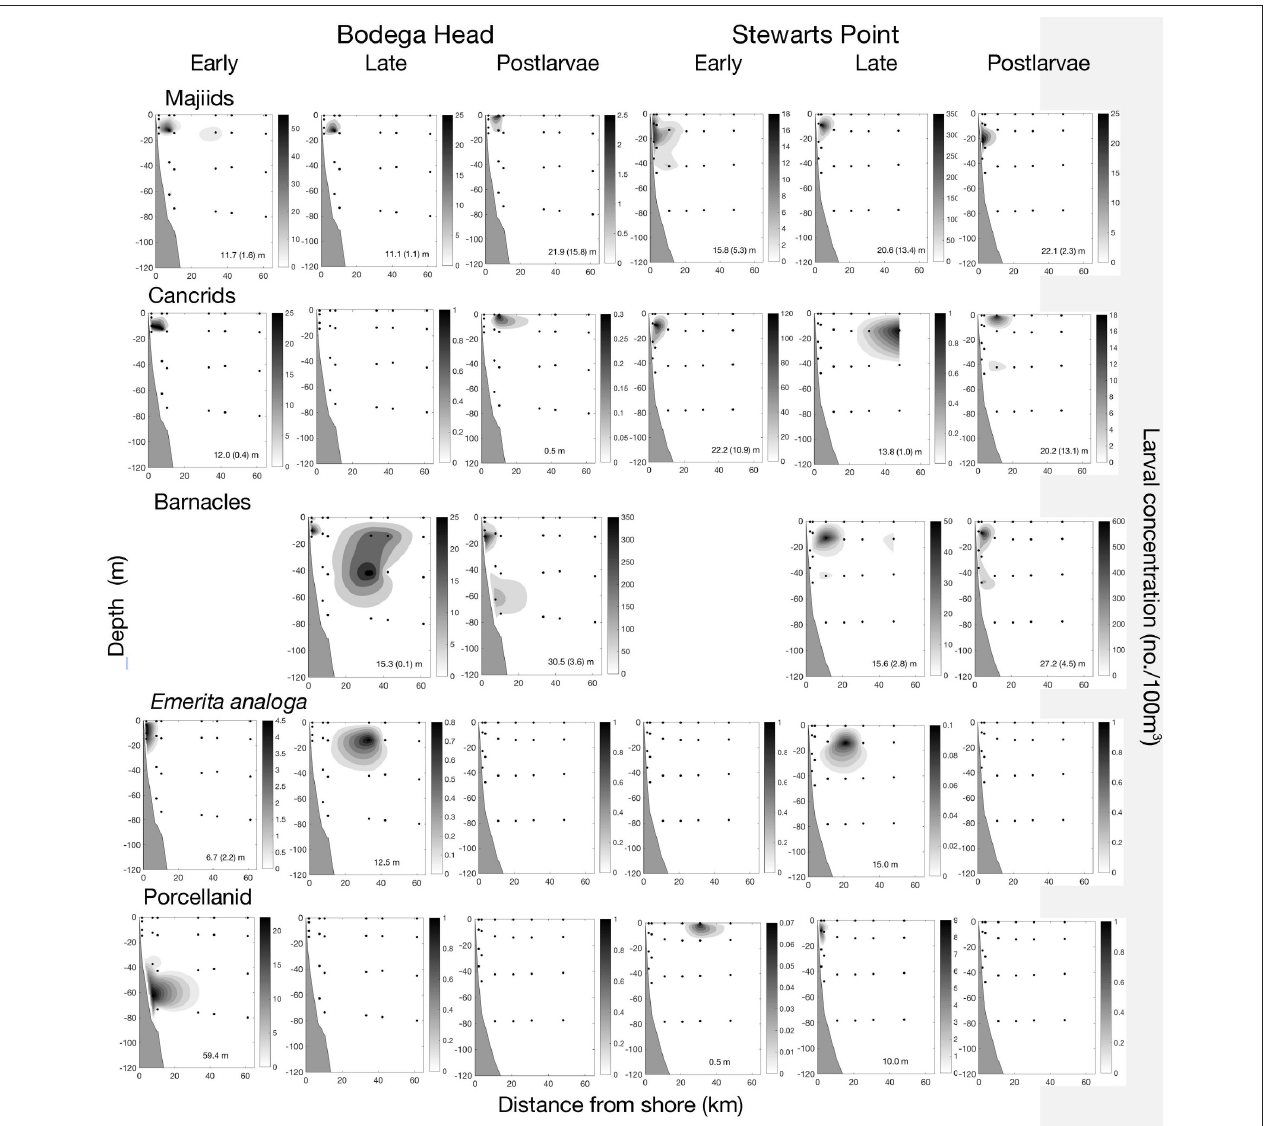
FIGURE 10 | Offshore larval development of 14 species in relation to distance from shore and depth off Bodega Head and Stewarts Point where larvae largely occurred < 11km from shore with late stages occurring > 32km from shore. First row of panels for seven majid crabs ( Pugettia richii, Pugettia producta, Pugettia gracilis, Scyra acutifrons, Mimulus foliatus, Oregonia gracilis, unidentified species); second row of panels for three cancrid crabs ( C . magister, C. productus, C. oregonensis ); third row of panels for two barnacles ( Balanus nubilus, Pollipes polymerus ); fourth row of panels for the mole crab ( Emerita analoga ); and fifth row of panels for an unidentified porellanid. The depth center of mass (ZCM; mean with SE in parentheses) is given at the bottom of each panel. ZCM with no variation shown in parentheses indicates species were collected during a single cruise, and separate groups of larvae within panels were collected during different cruises. Missing panel indicates that small larvae passed through